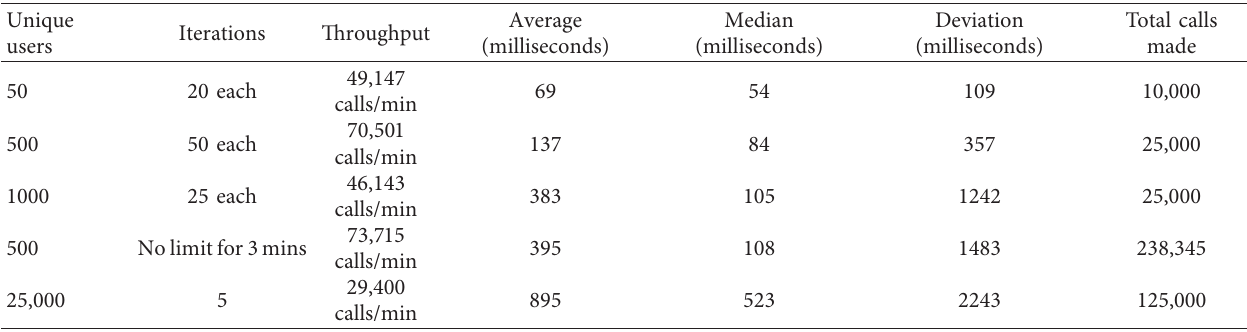
Køge st. Table 2: Performance of the web service in terms of throughput and response time according to the numbers of unique users and calls. Unique